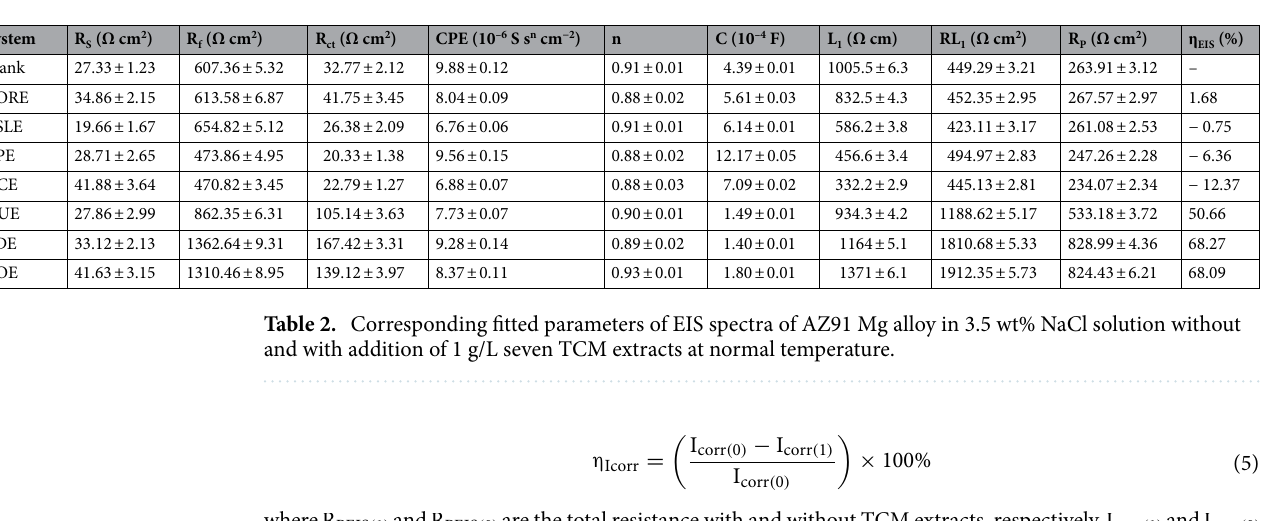
Fig. 2. The obtained polarization and impedance parameters were given in Tables 3 and 4. In general, it can be found that the polarization current density was progressively decreased with increasing the concentration of GUE, PDE and TOE from 0.5 to 2.0 g/L and then significantly increased when the concentration reached 2.5 g/L. The polarization resistance and the inhibiting efficiency ( η EIS and η Icorr ) show an opposite variation trend, i.e. a gradual increase till 2.0 g/L, afterwards a sharp reduction. It is well-documented that the organic inhibitors can yield the inhibition effect mainly by their adsorption onto the metal surface 36 . Nevertheless, the inhibitor at a low